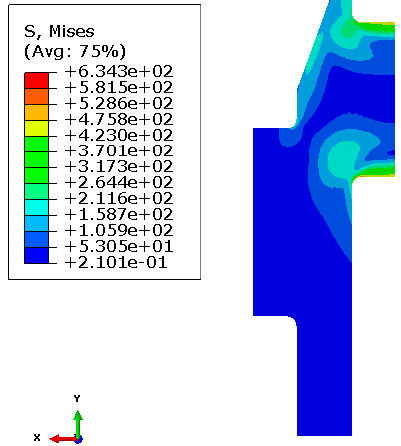
Figure 11. The residual stress field of the crankshaft.